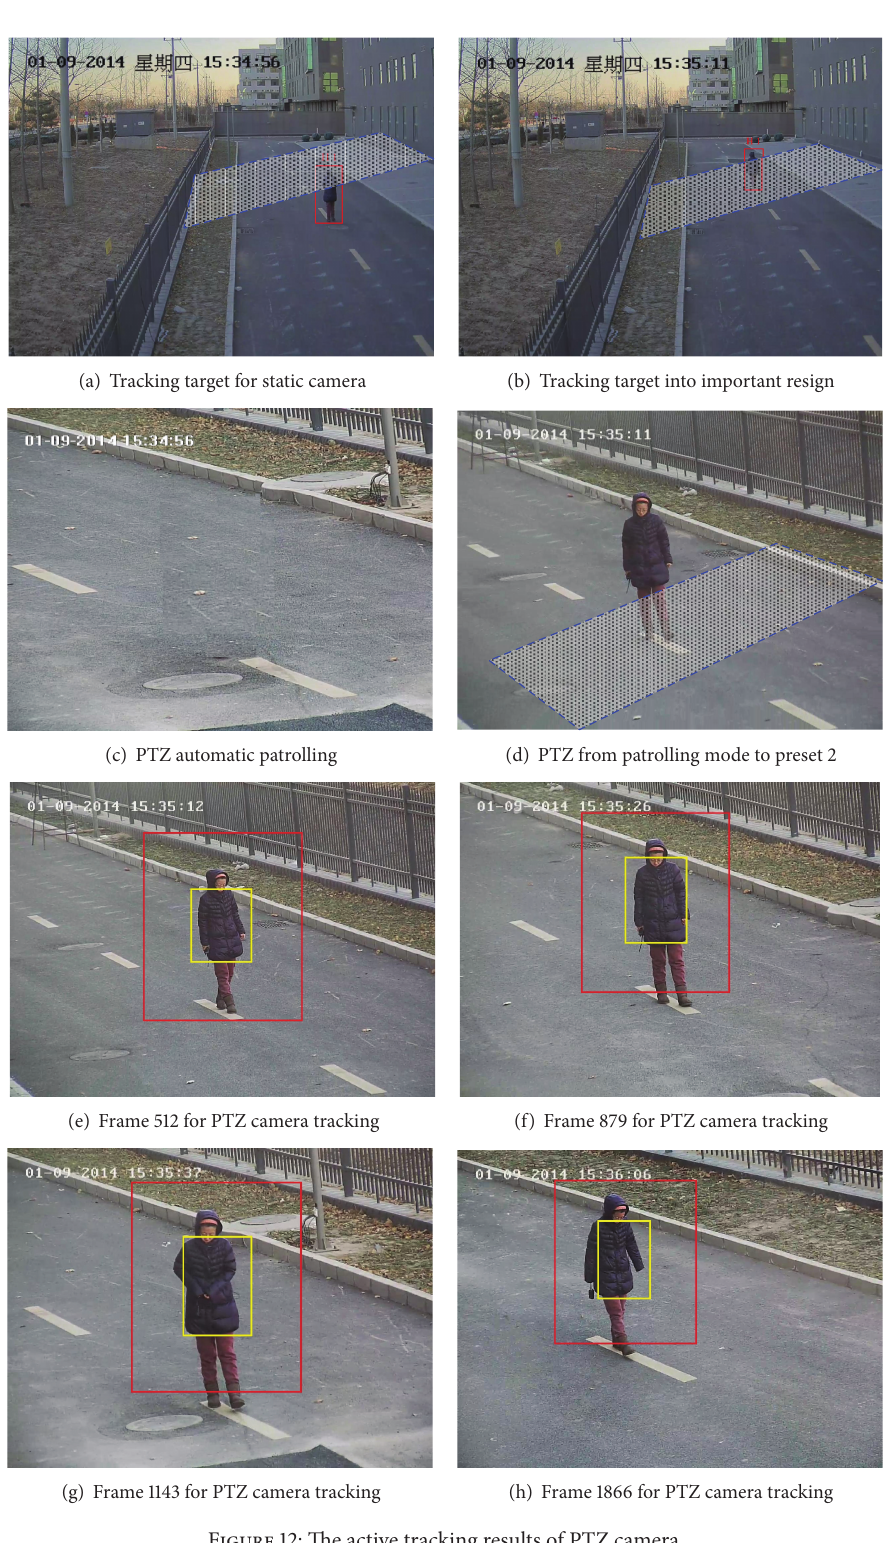
Figure 12: The active tracking results of PTZ